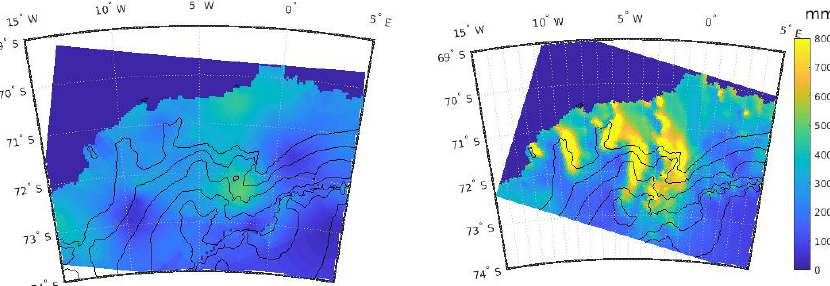
Figure 9. The visual comparison of the average annual snowfall accumulation over western Dronning Maud Land between the database from Rotschky et al. (2007) and the downscaled CESM2 member 1 (trained with ERA5) shows more pronounced asymmetrical patterns near sharp surface elevation changes. The difference in magnitude should be taken with caution as only the snowfall component is provided by the MASS2ANT database, while Rotschky et al. (2007) is the integration of the total surface mass balance.